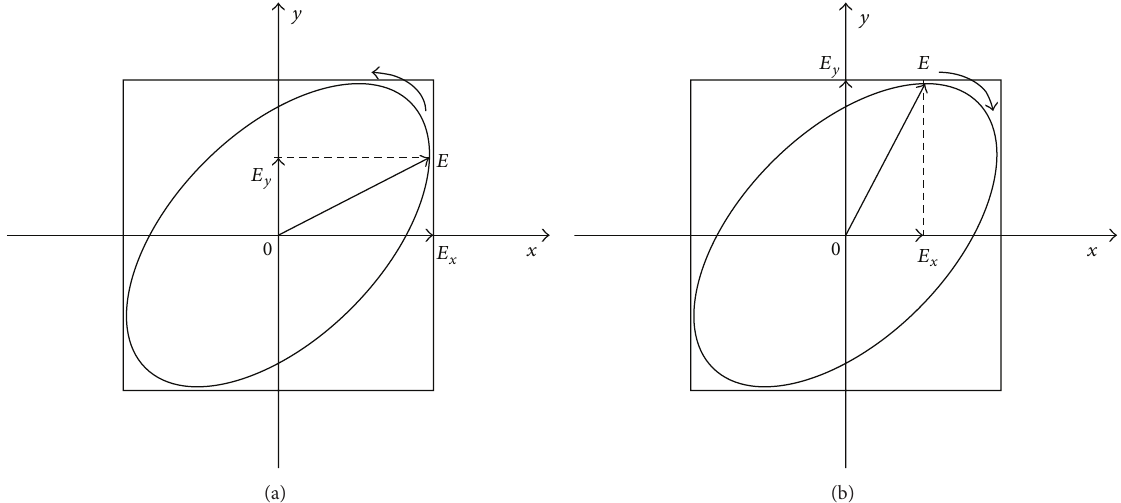
Figure 1: Left-hand circular polarization (LHCP) wave and right-hand circularly polarized (RHCP) wave.